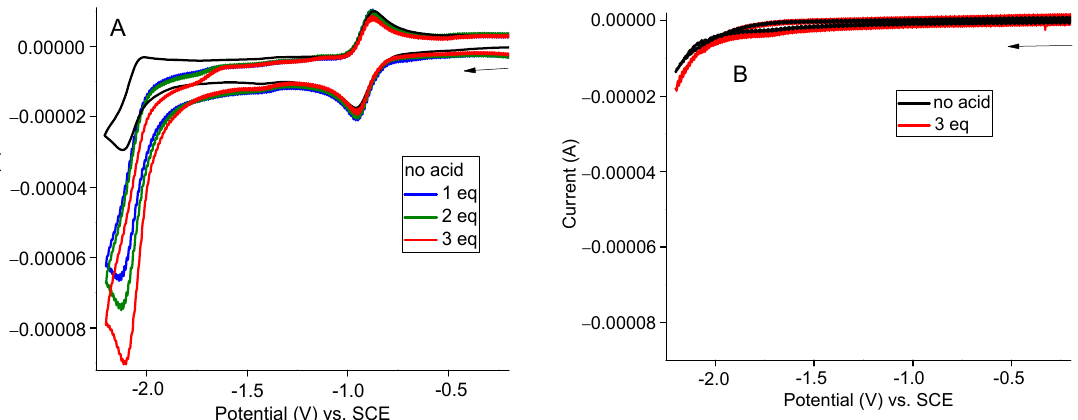
Figure 5. Cyclic voltammograms of [Co(TMFPP)] (1 mM) in 0.1 M n Bu 4 NBF 4 /DMF recorded in the absence (black trace) or in the presence of 1 to 3 eq. CH 3 COOH in DMF at 100 mV s − 1 ( A ), Blank test without catalyst ( B ).